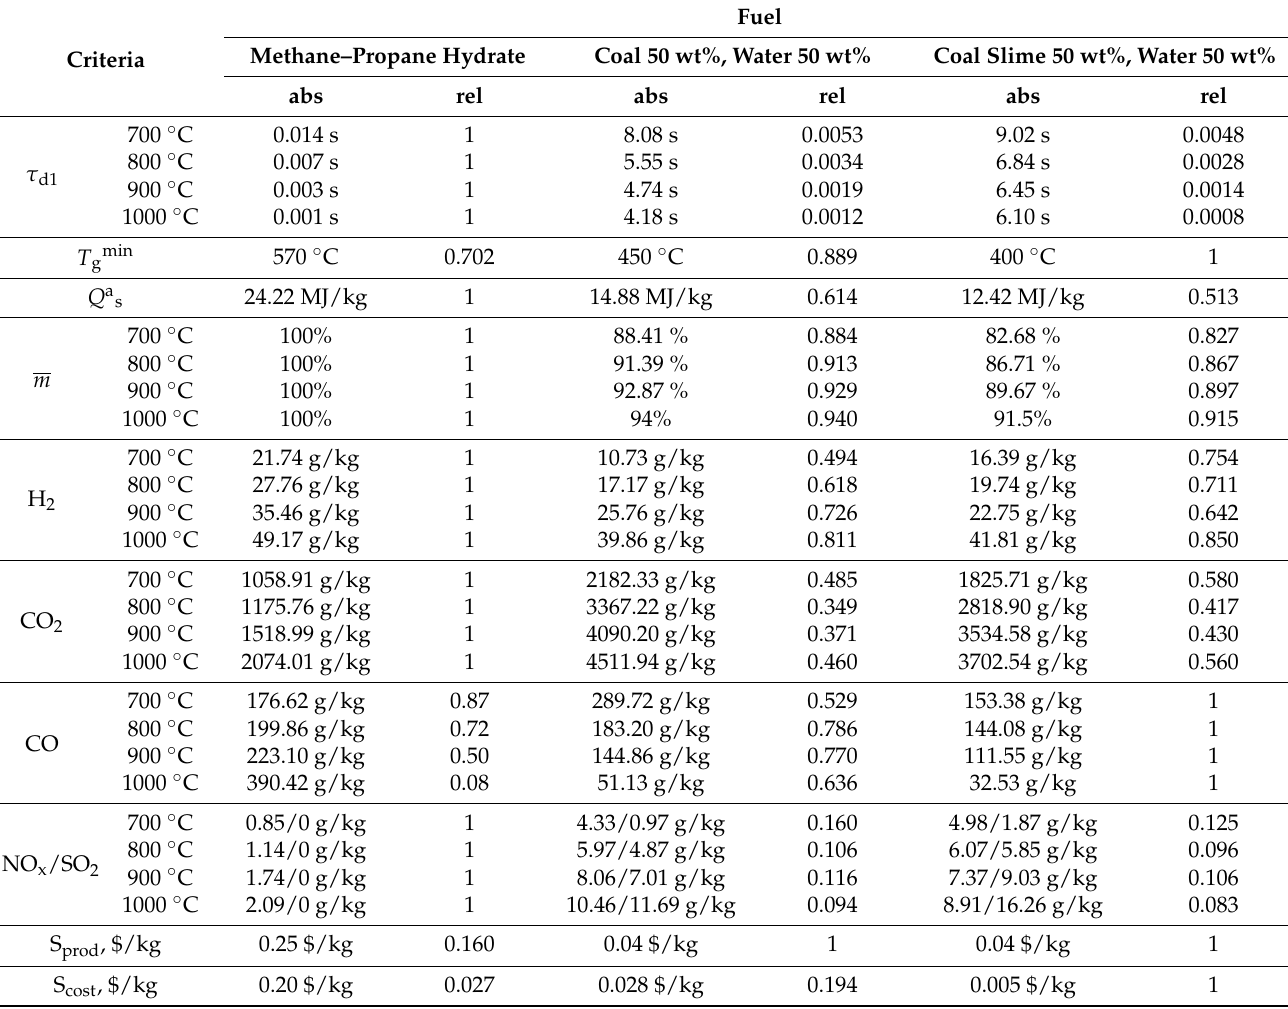
Table 6. Absolute (abs) and normalized (rel) values of fuel efficiency criteria for WSM.